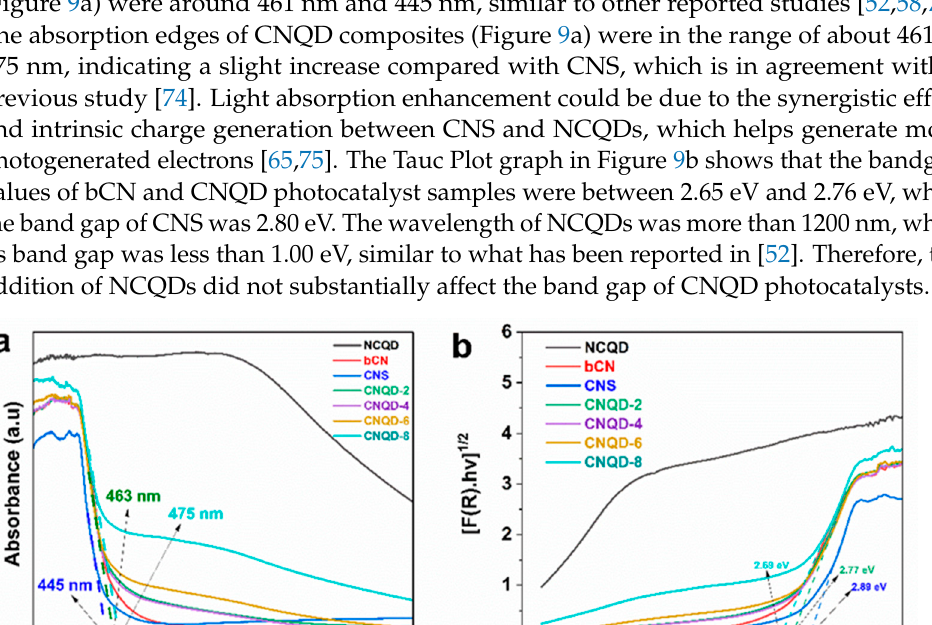
Figure 9. UV/Vis-DRS ( a ) and Tauc plots ( b ) of NCQD, bCN, CNS, and CNQD photocatalysts.